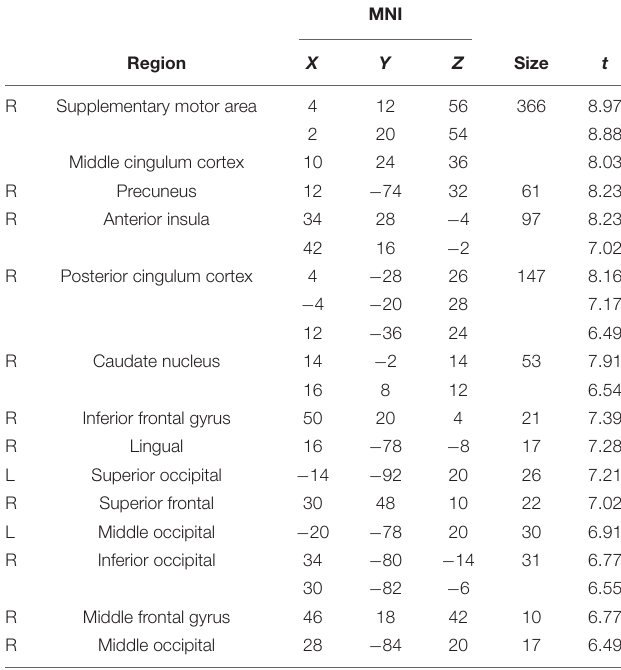
TABLE 3 | Maintenance of rhythmic patterns (MAINTENANCE > SUPPRESSION).